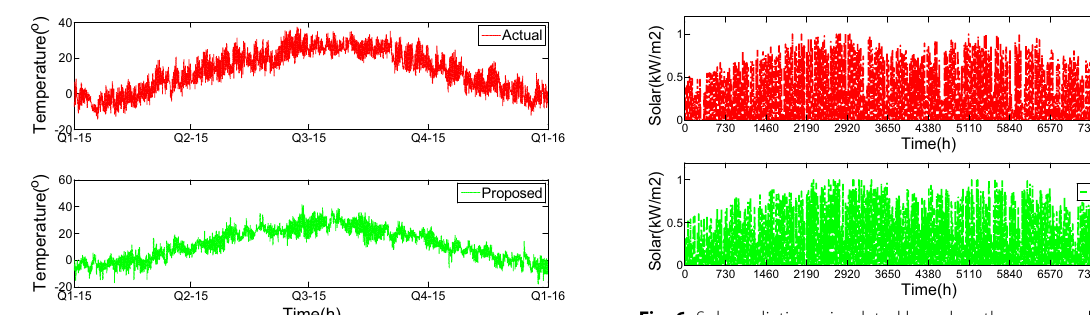
Fig. 6 Solar radiations simulated based on the proposed model